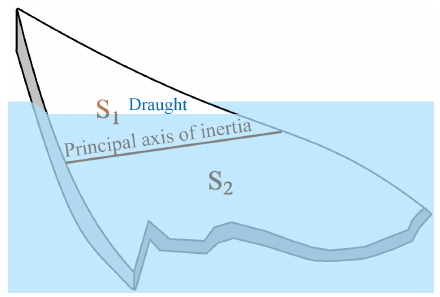
Figure 2. Schematic representation of a thin floating